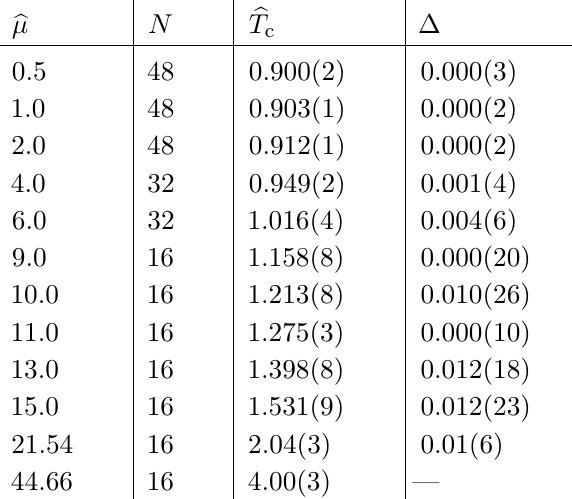
— µ values considered in this work. As µ decreases, b b either from the peak of the Polyakov loop susceptibility or from c